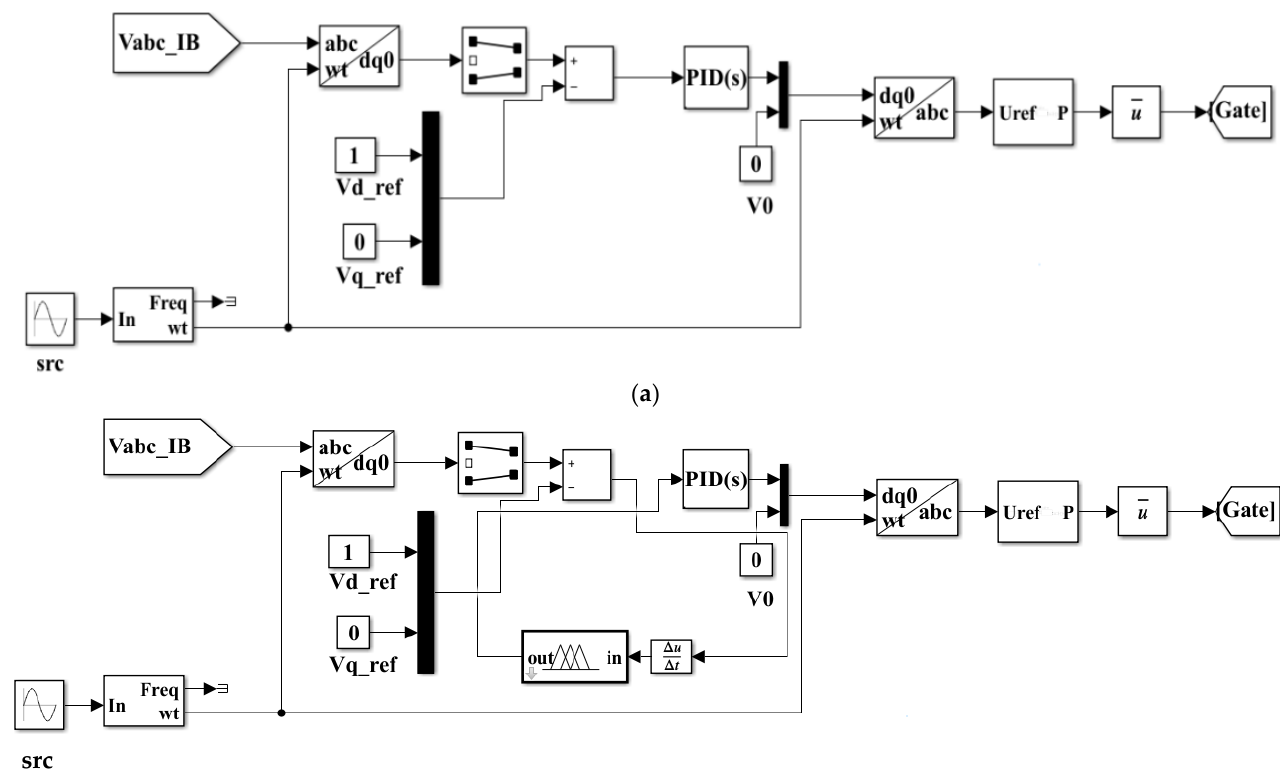
Figure 10. ( a ) Schematic diagram of conventional PID controller. ( b ) Schematic diagram of conventional PID controller.